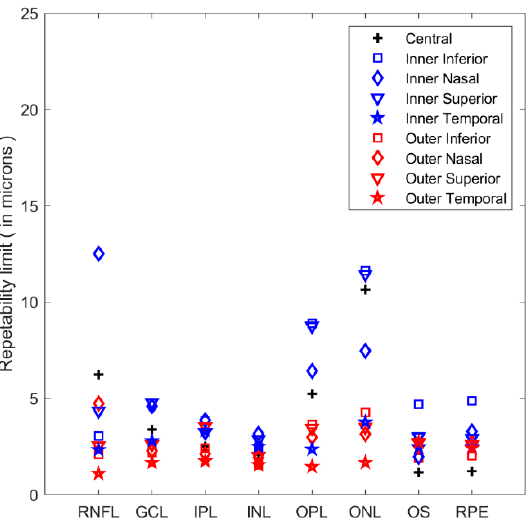
Figure 2. Repeatability limit values of the measurements for each retinal layer in each sector of the ETDRS map. Retinal Nerve Fiber Layer (RNFL), Ganglion Cell Layer (GCL), Inner Plexiform Layer (IPL), Inner Nuclear Layer (INL), Outer Plexiform Layer (OPL), Outer Nuclear Layer (ONL), Outer Segment (OS), and Retinal Pigment Epithelium (RPE).